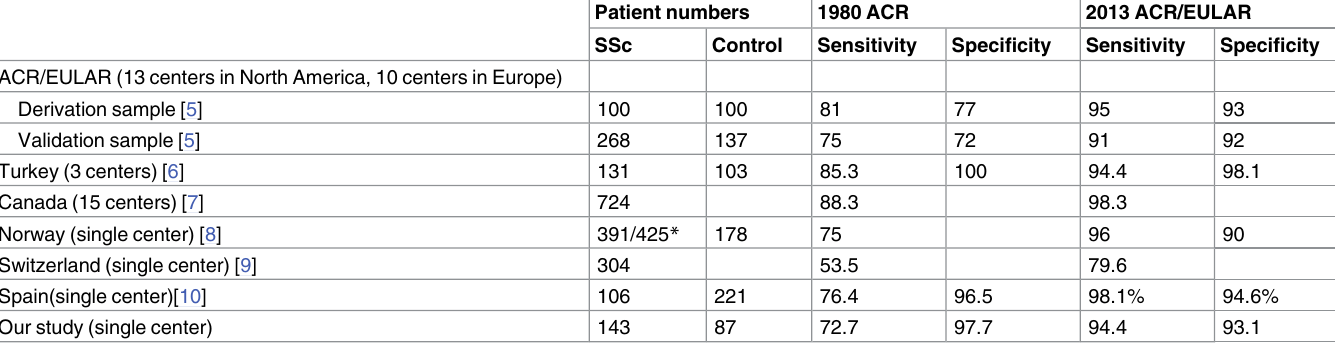
Table 3. Sensitivity and specificity of 1980 ACR and 2013 ACR/EULAR criteria in different